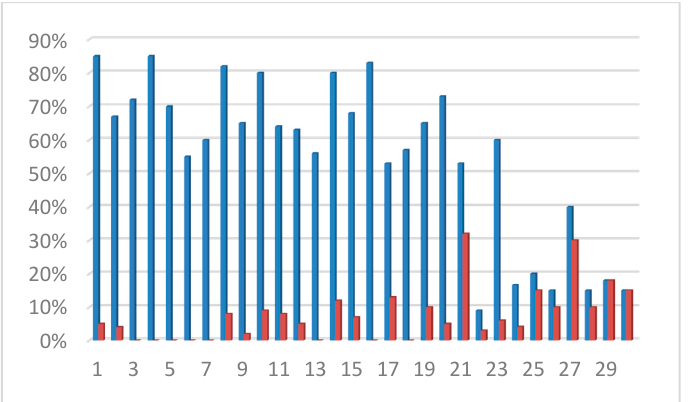
Figure 6. Average of the bleeding on probing index values before (T1) and after treatment (T3). Patients from 1 to 10 were included in group A, from 11 to 20 were in group B and from 21 to 30 were in group C. The total average decrease owas 80.27%, with group A’s average decrease being 97.0%, group B’s average decrease being 95.0% and group C’s average decrease being 48.8%.